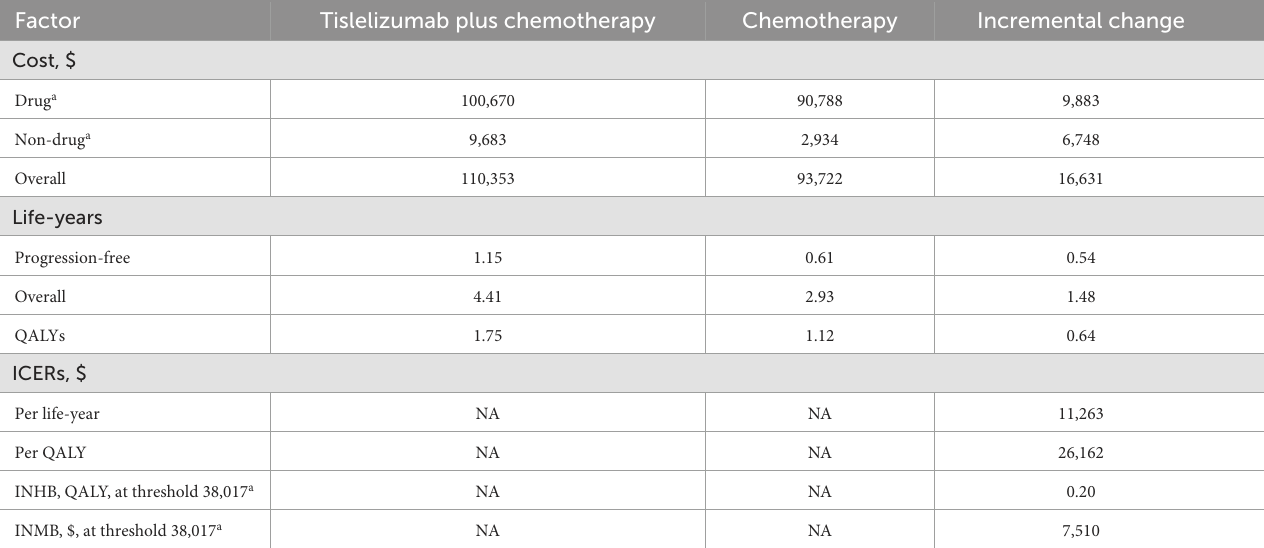
TABLE 2 Summary of cost and outcome results in the base-case analysis.